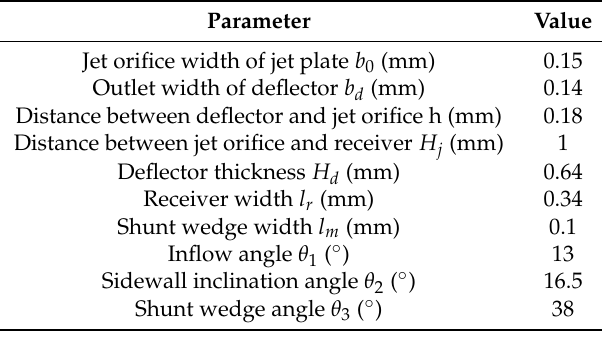
Figure 4. Definition of geometric parameters. Table 3. Values of geometric parameters.